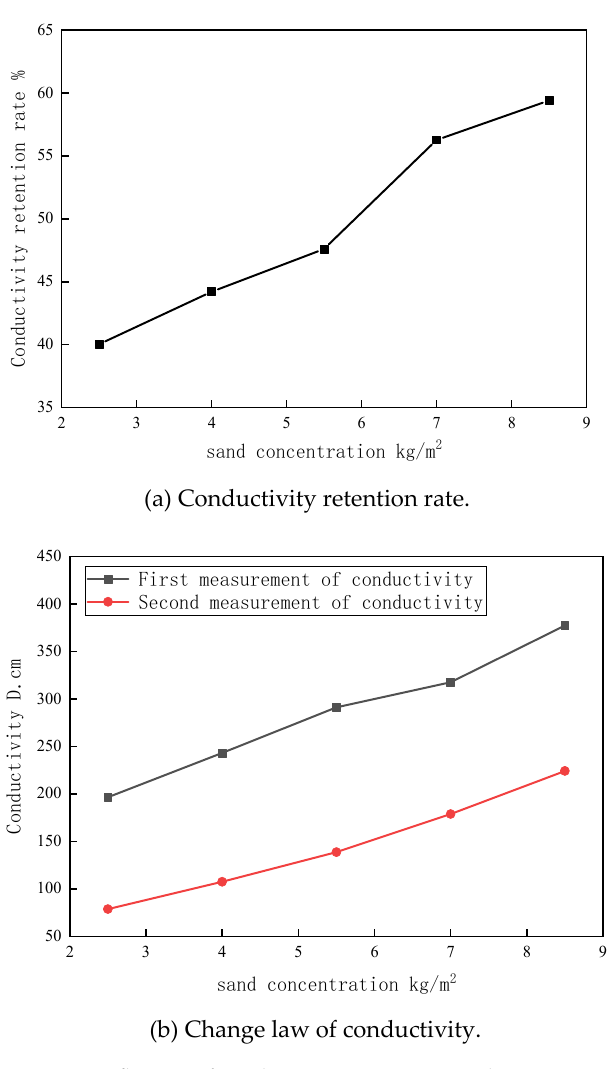
Figure 2. Influence of sand concentration on conductivity.